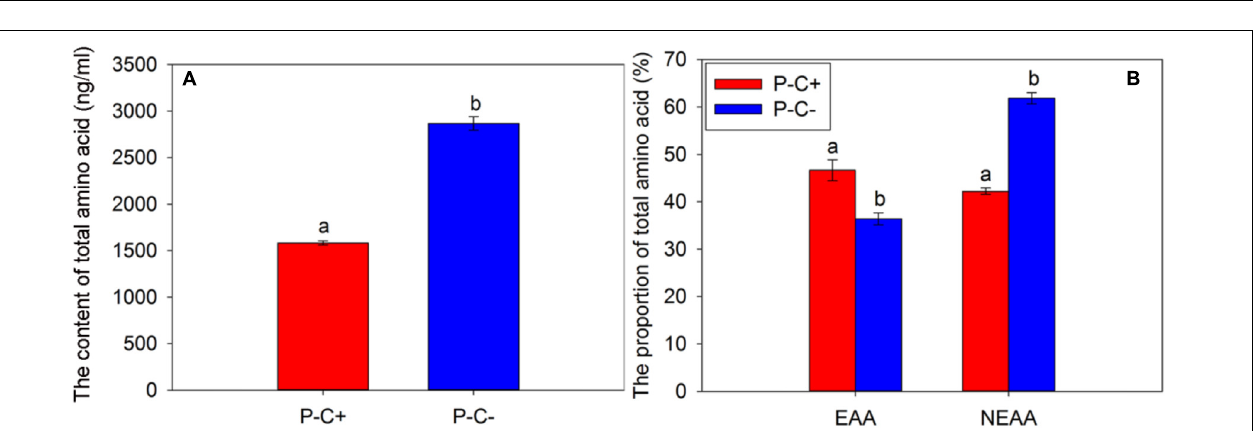
FIGURE 2 | The species of free amino acids (FAAs) in the phloem sap of citrus plants. “C+” and “C − ” represent C Las-infected and C Las-free citrus plants, respectively. Values are represented as mean ± SE, and ∗ over the bars means significant differences between groups at P < 0.05.